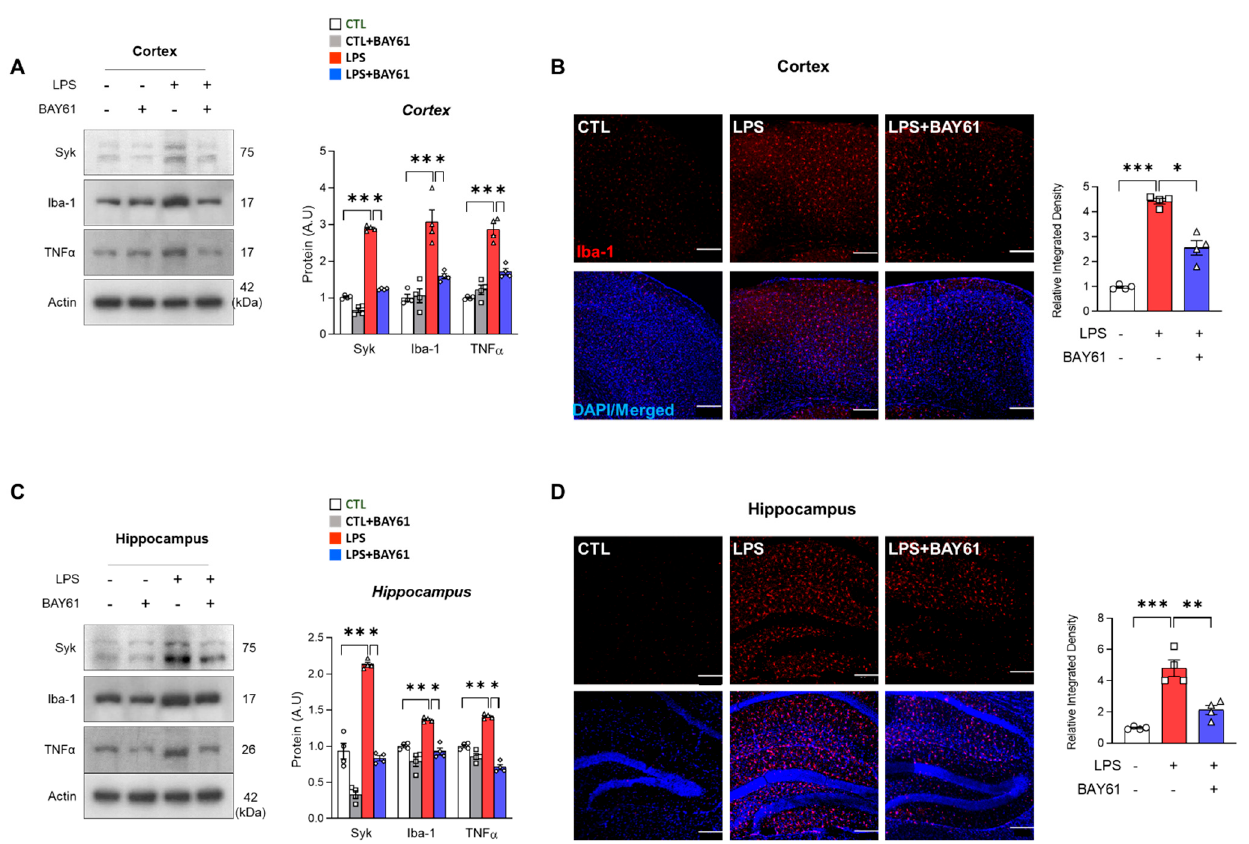
Figure 2. Effects of Syk against LPS-induced neuroinflammation in mice models. Western blot results of of Syk, Iba-1, and TNF α in the mice ( A ) cortex and ( C ) hippocampus ( n = 4 mice/per group). Representative immunofluorescence images of Iba-1 expression in the ( B ) cortex and ( D ) hippocampus of the experimental mice’s brains. Bar graph color, white: control, grey: control with BAY61-3606, red: LPS, blue: LPS with BAY61-3606. Scale bars, 100 µ m. Values indicate the mean ± SEM. The significant differences have been given in the graphs as follows: * p < 0.05, ** p < 0.005, *** p < 0.0001 compared with a group of interests and determined by one-way ANOVA followed by Tukey’s multiple comparison test. Abbreviation: Syk, tyrosine-protein kinase; LPS, lipopolysaccharide; Iba-1, ionized calcium-binding adaptor molecule 1; TNF α , tumor necrosis factor alpha.